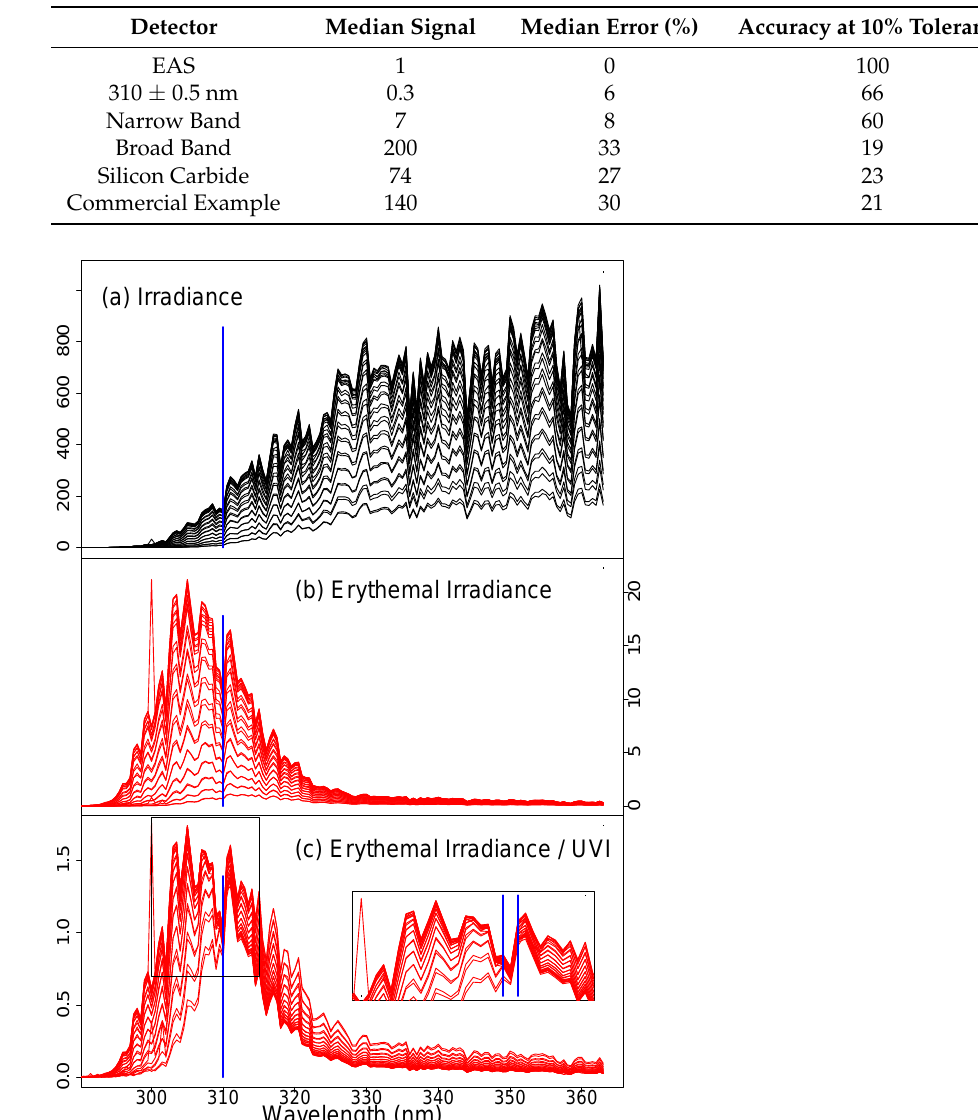
Table 1. Modeled performance of spectral sensitivity functions in Figure 4. Median signal is relative to EAS. Accuracy is the percentage of spectra whose UVI is predicted with an error less than 10%.